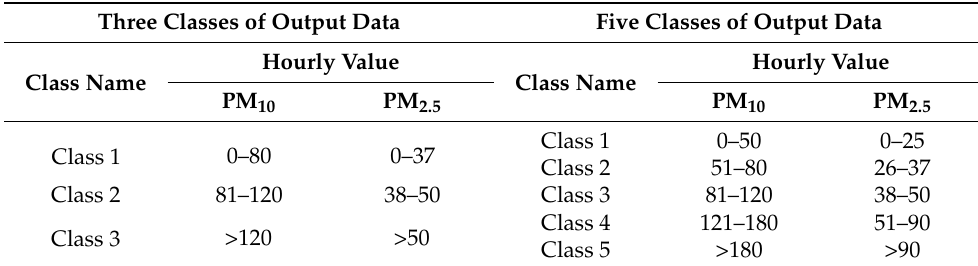
Table 2. The class assignments in the experiments were determined according to the standard Thailand PM